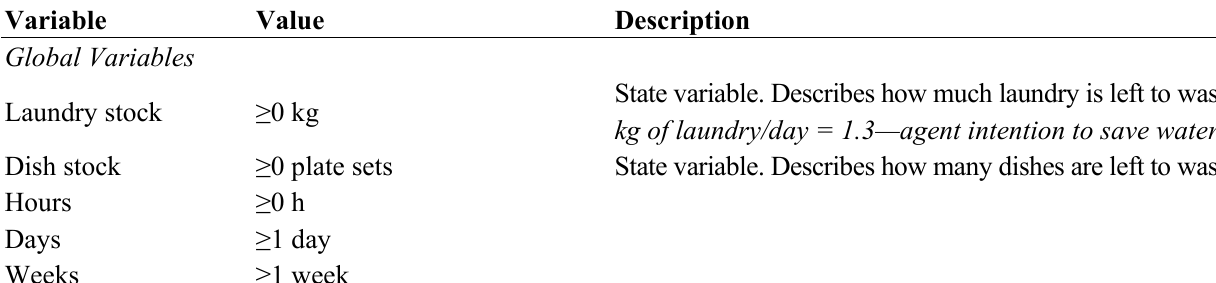
Table 1. A list of the model behavioral